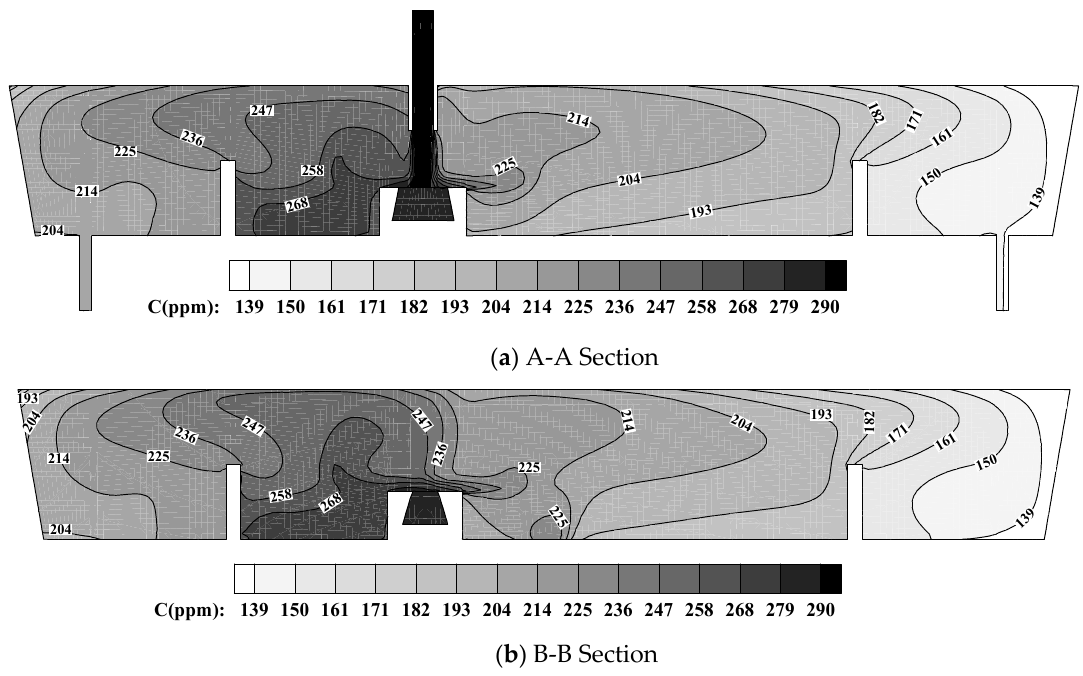
Figure 10. Inclusion volume concentration distribution in the original tundish.